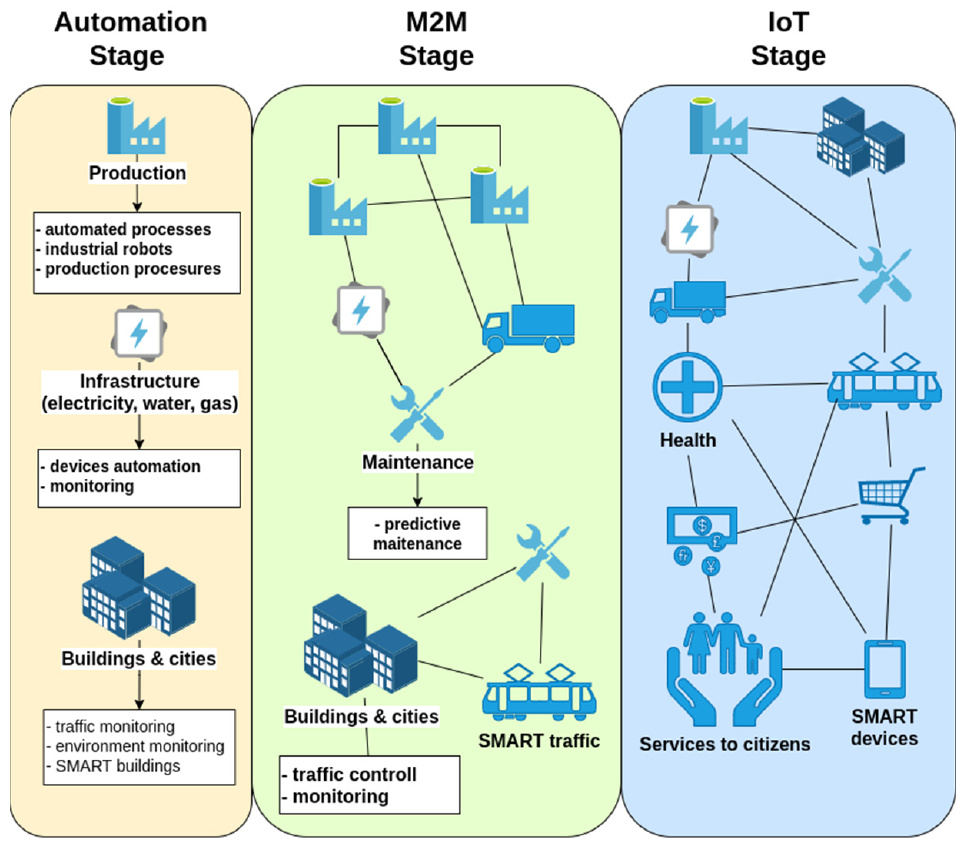
Figure 3. Stages of IoT and M2M implementation.